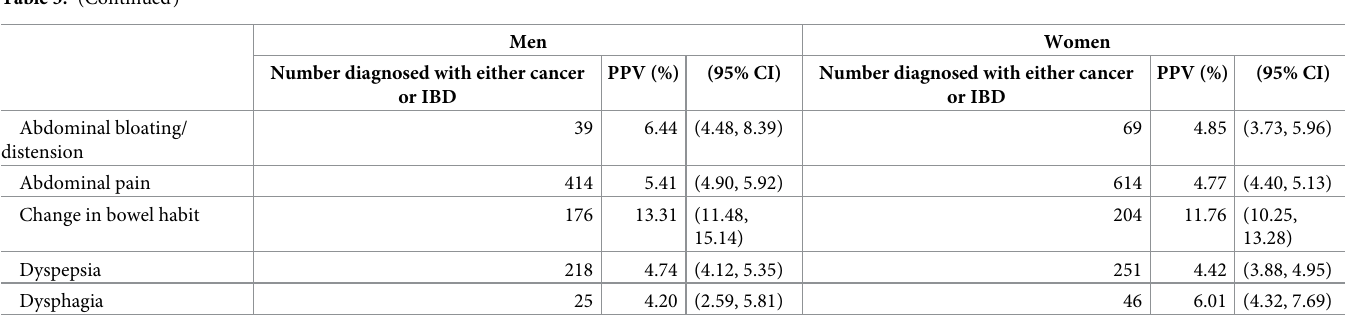
Among cancer cases, the relative distribution of different cancer sites by symptom cohort (i.e., the cancer site case mix of each symptom cohort among diagnosed cases) is depicted in S1 Fig . Cancer cases diagnosed after presentation with either change in bowel habit or rectal bleeding were most likely diagnosed with colon and rectal cancer, whereas after presentation with dysphagia, esophageal was the most likely cancer diagnosis, noting, however, that across all 6 symptoms, a substantial minority of patients were diagnosed with “other” cancers.